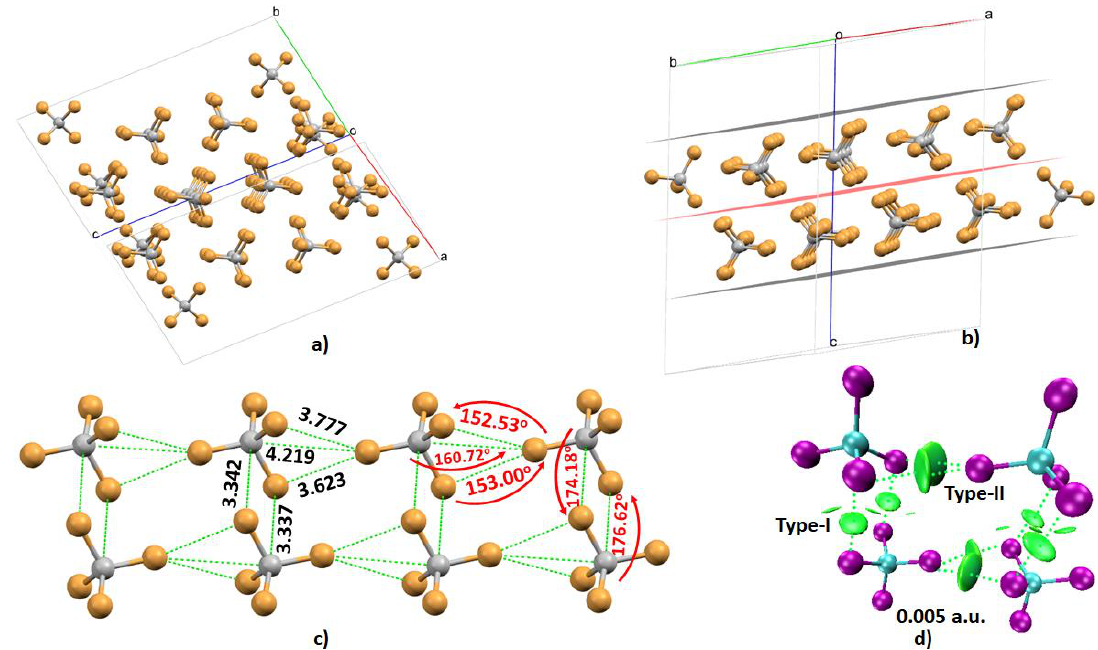
Figure 12. The ball-and-stick models of the ( a , b ) unit cell and ( b ) the (002) slicing pattern of the CBr 4 crystal (CSD ref code: CTBROM06). ( c ) Selected local distances between the CBr 4 monomers in the crystal. ( d ) The 0.005 a.u. isosurface plot corresponding to four CBr 4 monomer units is illustrated, and was obtained with the IGM analysis.